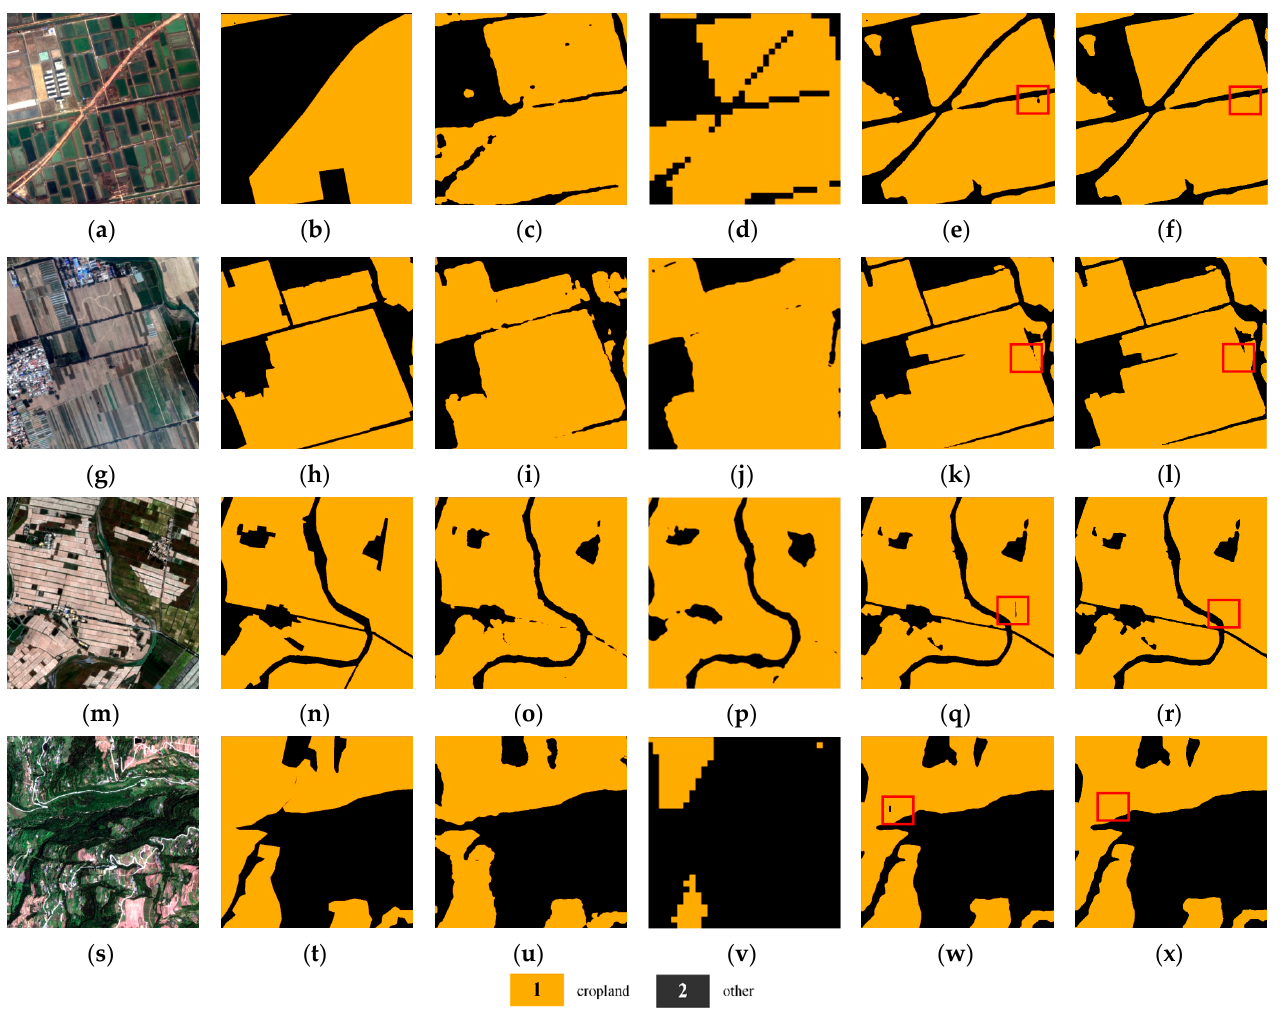
Figure 15. Comparison of different semantic segmentation methods in the GID dataset for cropland extraction in different geographic scenarios. ( a , g , m , s ) True ‐ color images of different geographic scenes, ( b , h , n , t ) ground truth labels, ( c , i , o , u ) semantic segmentation results of Deeplabv3+, ( d , j , p , v ) semantic segmentation results of UperNet, ( e , k , q , w ) semantic segmentation results of HRNet ‐ CFR, and ( f , l , r , x ) the morphological post ‐ processing results of HRNet ‐ CFR (the red boxes marked in the last two columns are to better highlight the difference between before and after morphological post ‐ processing).